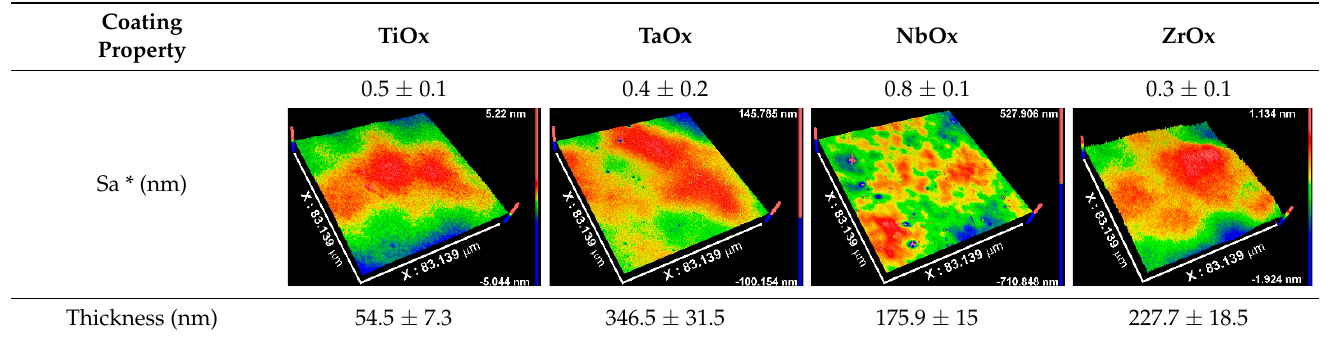
Table 2. Roughness, representative images of the surface topography, and thickness of the metal oxide coatings.